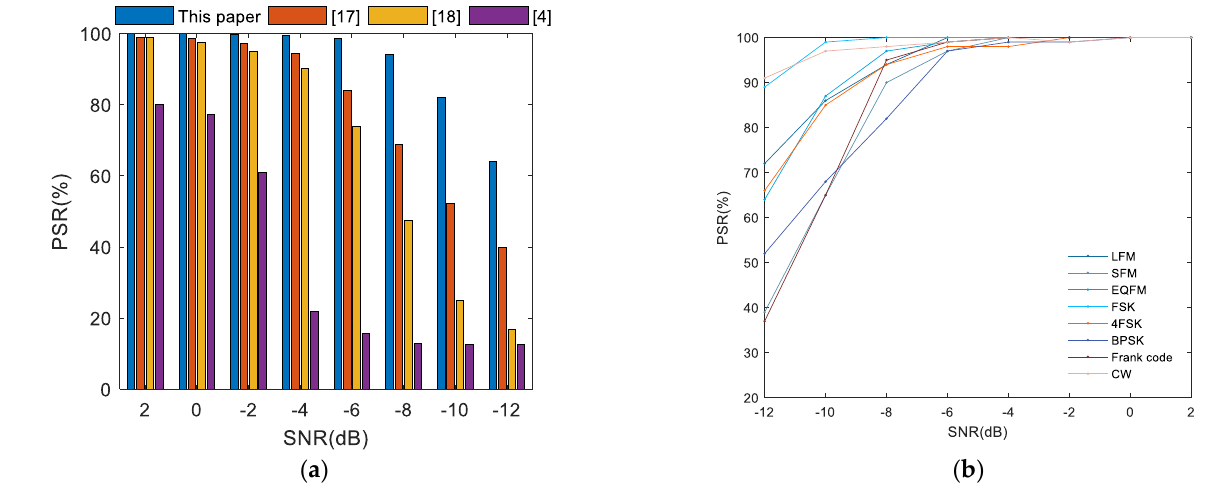
Figure 9. Recognition performance as a function of the SNR. ( a ) Overall recognition accuracy; ( b ) Recognition accuracy of eight kinds of signals.